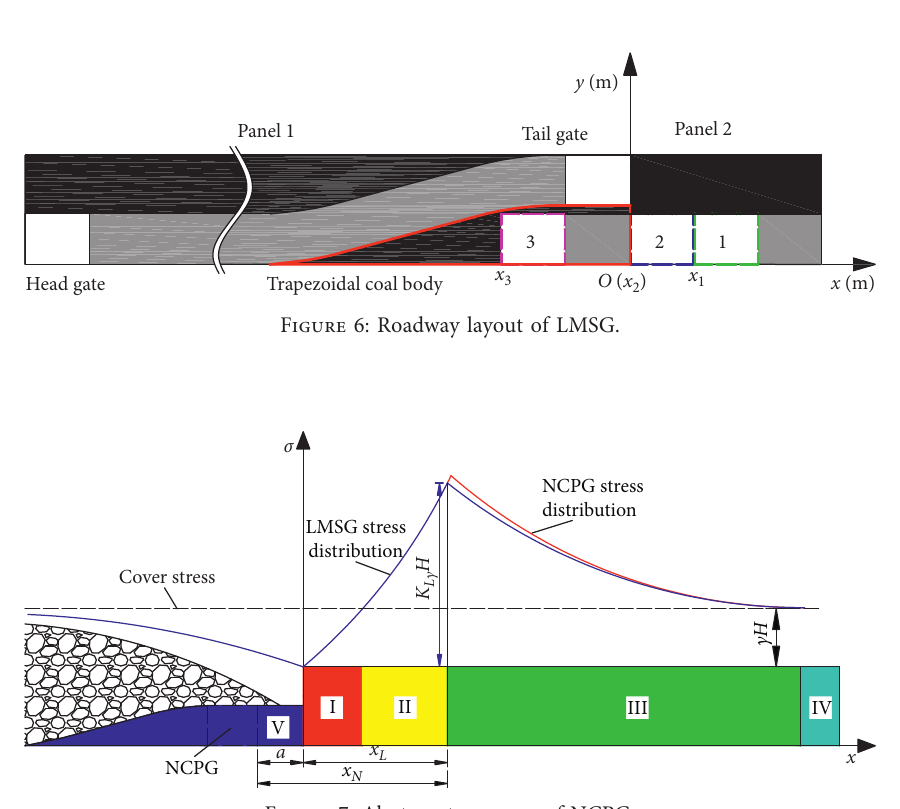
Figure 7: Abutment pressure of NCPG.